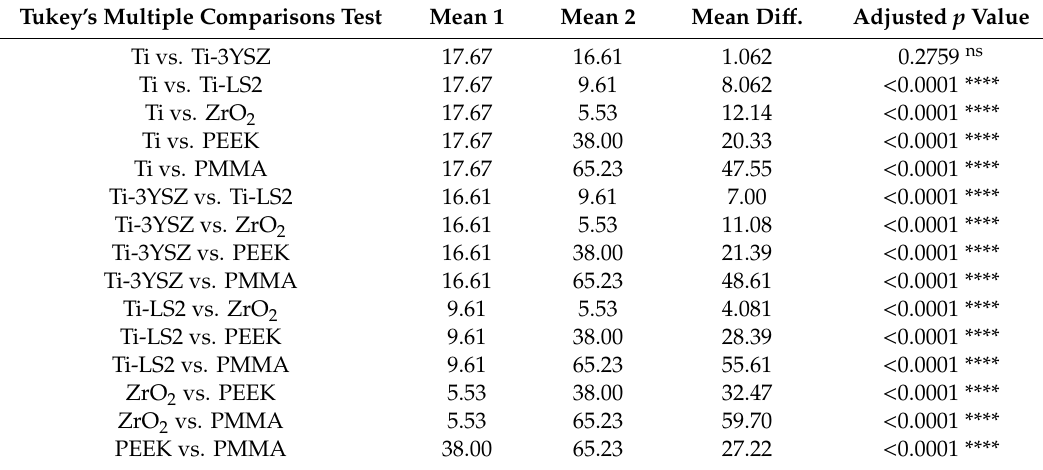
Table 2. Multiple comparisons of surface roughness (nm) among groups (n = 10 for each group) by Tukey’s test and significant difference of means at the p ≤ 0.05 level: **** - p < 0.0001. Non-significant (ns) – p > 0.05.